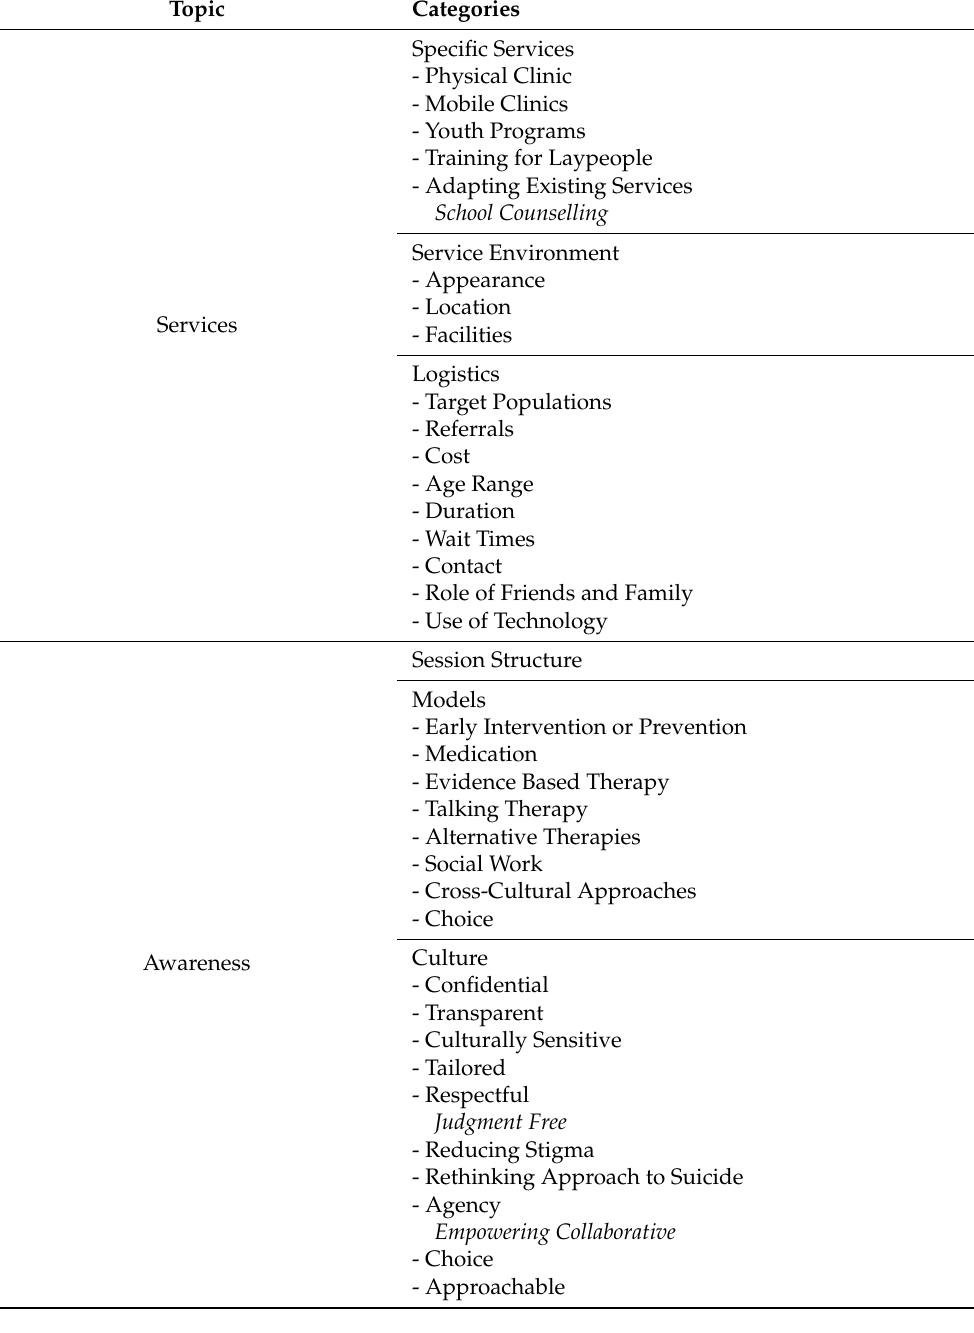
Table 2. Initial categorization